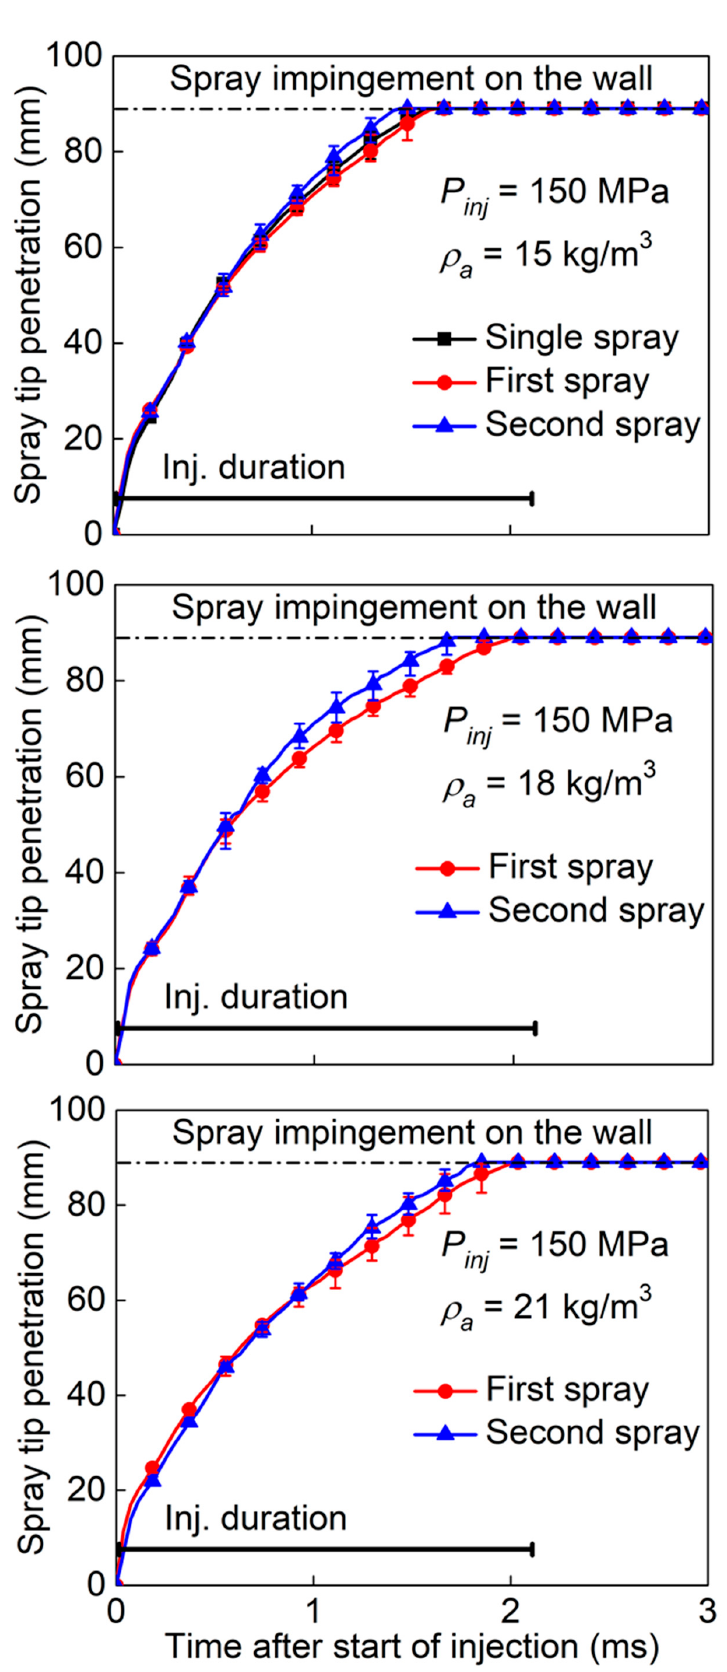
Figure 21. Comparing results of spray tip penetration between the first spray and second spray under various surrounding gas densities.